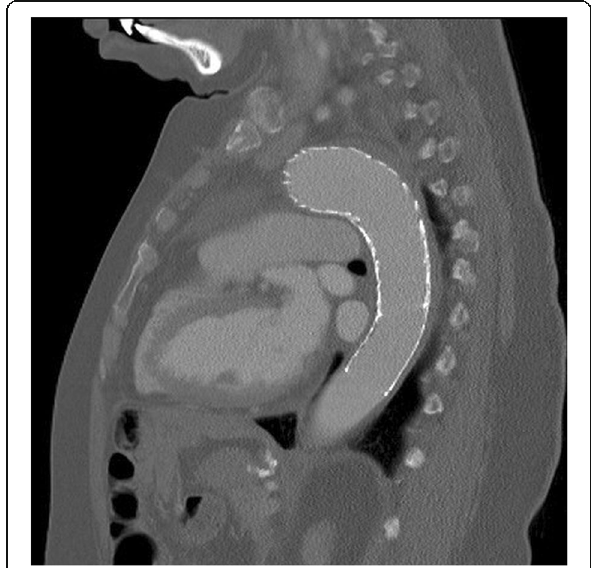
Fig. 5 Follow up CTA (sagittal view) one month after TEVAR showing widely patent aortic stent graft without any evidence of